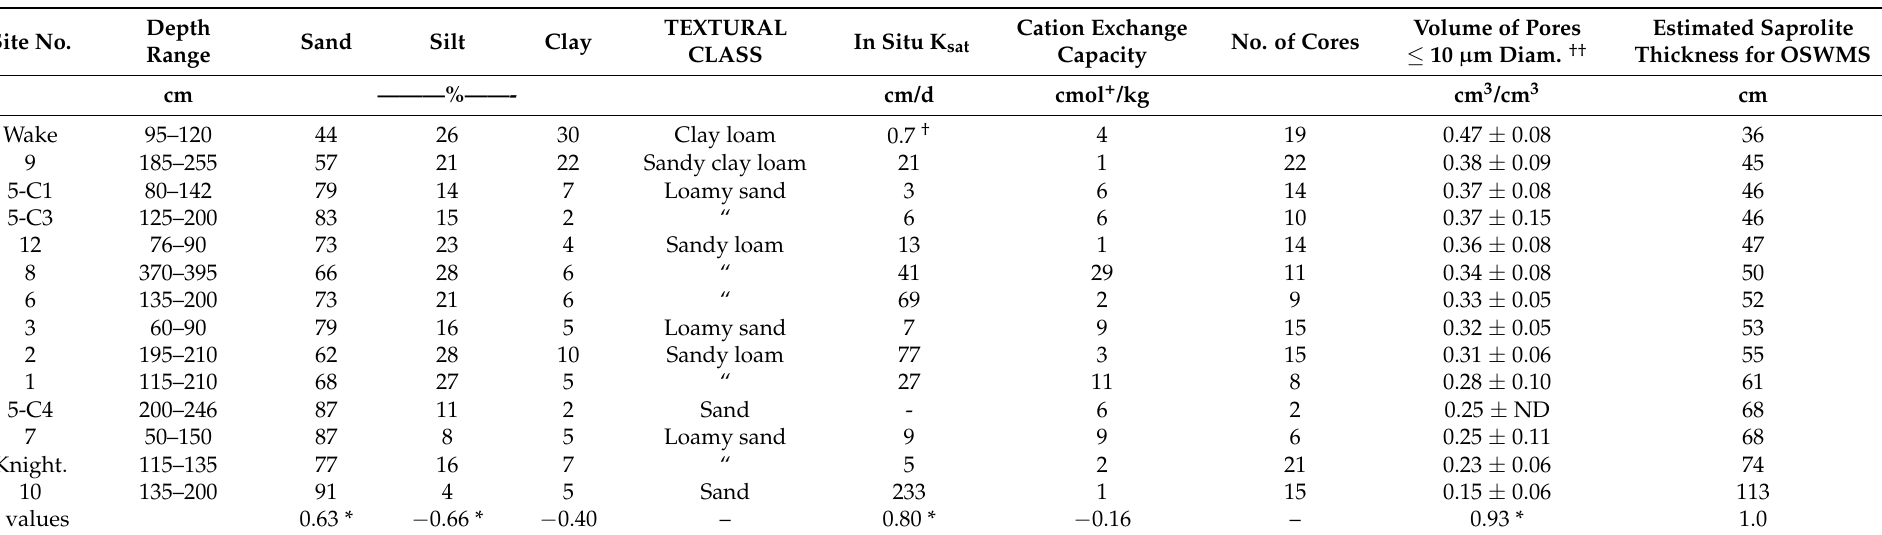
Table 2. Selected properties for saprolites studied and estimated thickness of saprolite needed to filter E. coli from wastewater using Equation (3). Correlation coefficients show relationship between a property and estimated saprolite